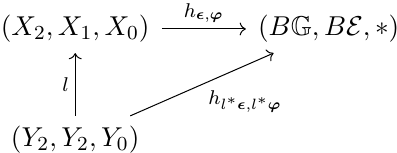
Figure 23 . Pullback of field configurations may be defined in terms of the associated maps to the classifying space: ( l ∗ (cid:15) , l ∗ ϕ ) corresponds to the map l ◦ h